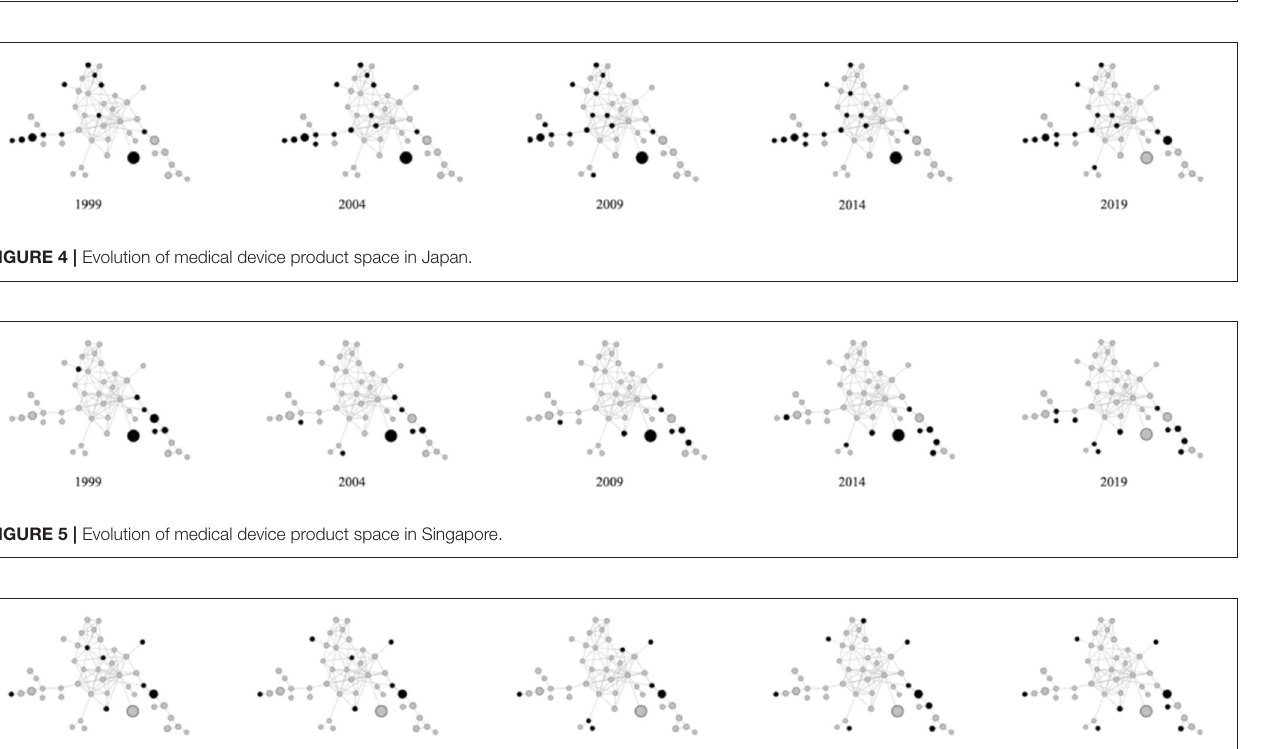
FIGURE 3 | Evolution of medical device product space in China.